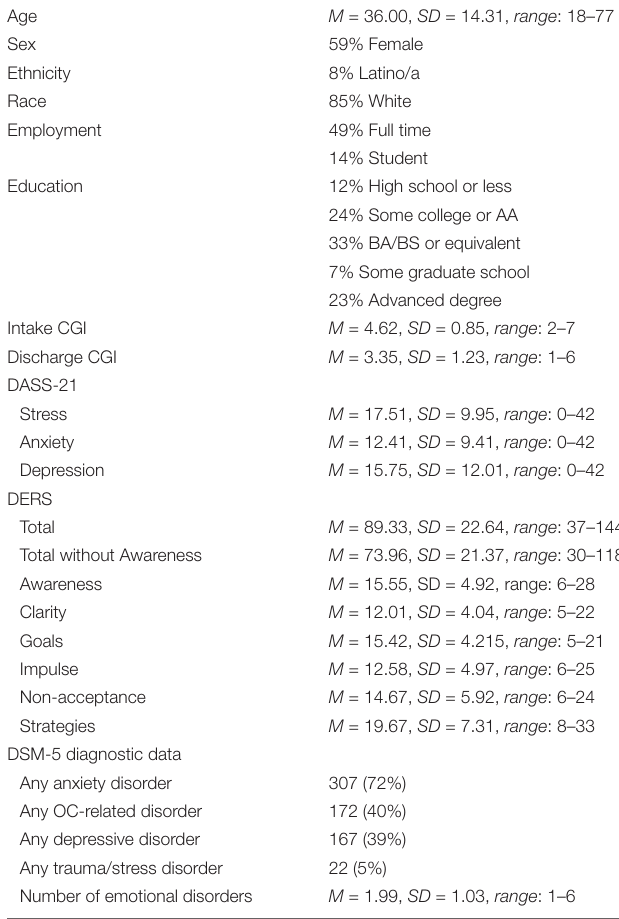
TABLE 1 | Demographic and clinical